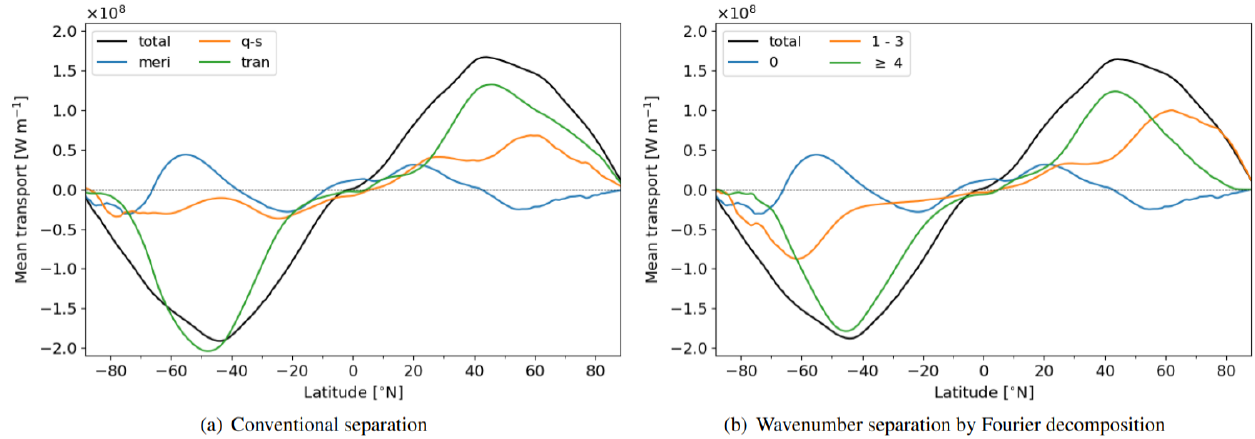
Figure 1. Different separation methods of the vertically integrated, zonal-mean, northward transport of energy from ERA5 as a mean over the years 1979 to 2018. (a) The conventional partitioning into the meridional overturning circulation (meri), quasi-stationary (q-s), and transient (tran) eddies, as performed by Oort and Peixóto (1983). (b) A decomposition into transport by different spatial scales defined by wavenumbers as suggested by Graversen and Burtu (2016). Transport by wave 0 provides the meridional overturning circulation. The sum of transport by waves 1–3 is often associated with planetary transport, whereas waves with larger wavenumbers are considered to be of synoptic scale. (Fig. S1b), different from the maximum zonally integrated transport peaking at 41 ◦